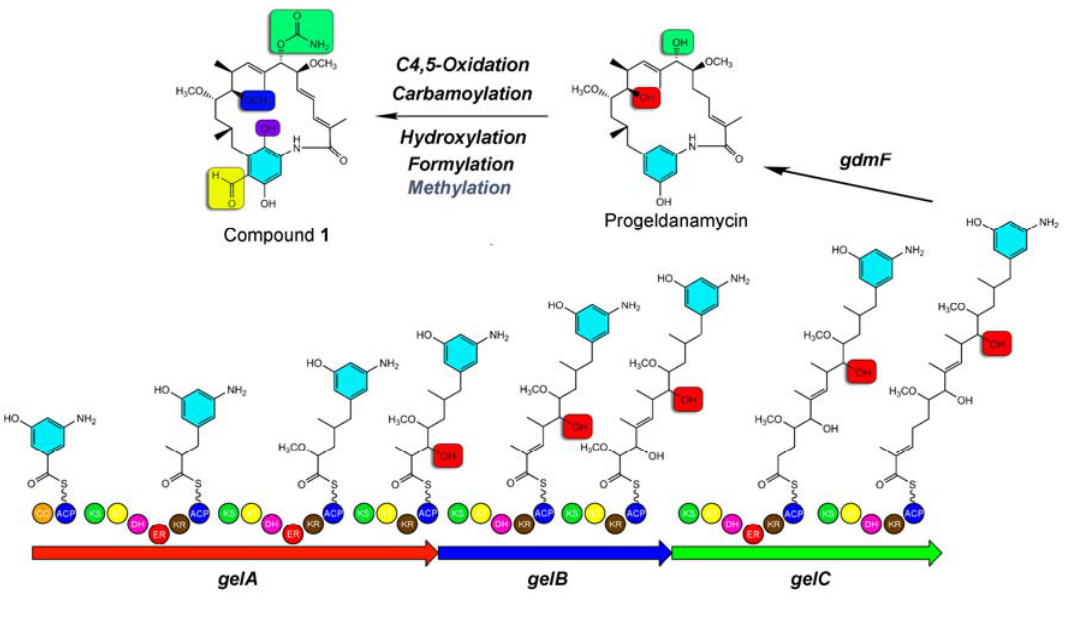
Figure 3. Speculated biosynthetic pathway of compound 1